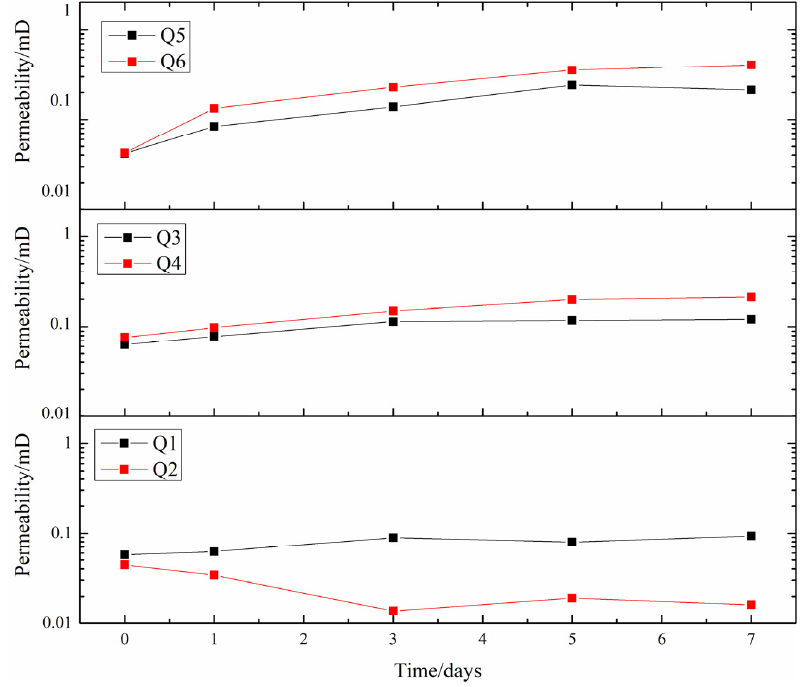
Figure 9. Permeability analysis of shale core samples during CO 2 treatment.